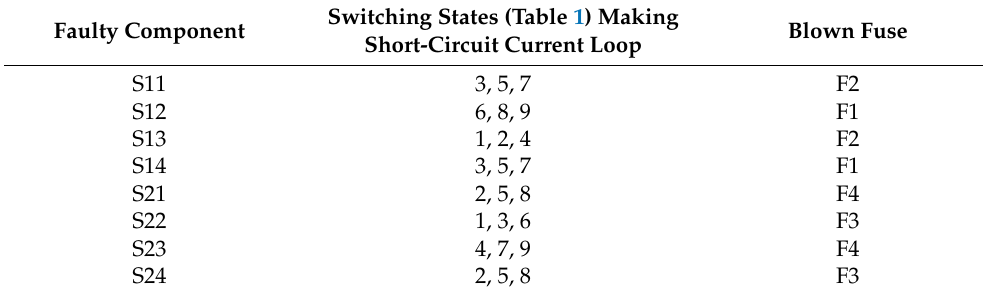
Table 3. Switching states making short-circuit current loop corresponding to each component. Switching States (Table 1) Faulty Component